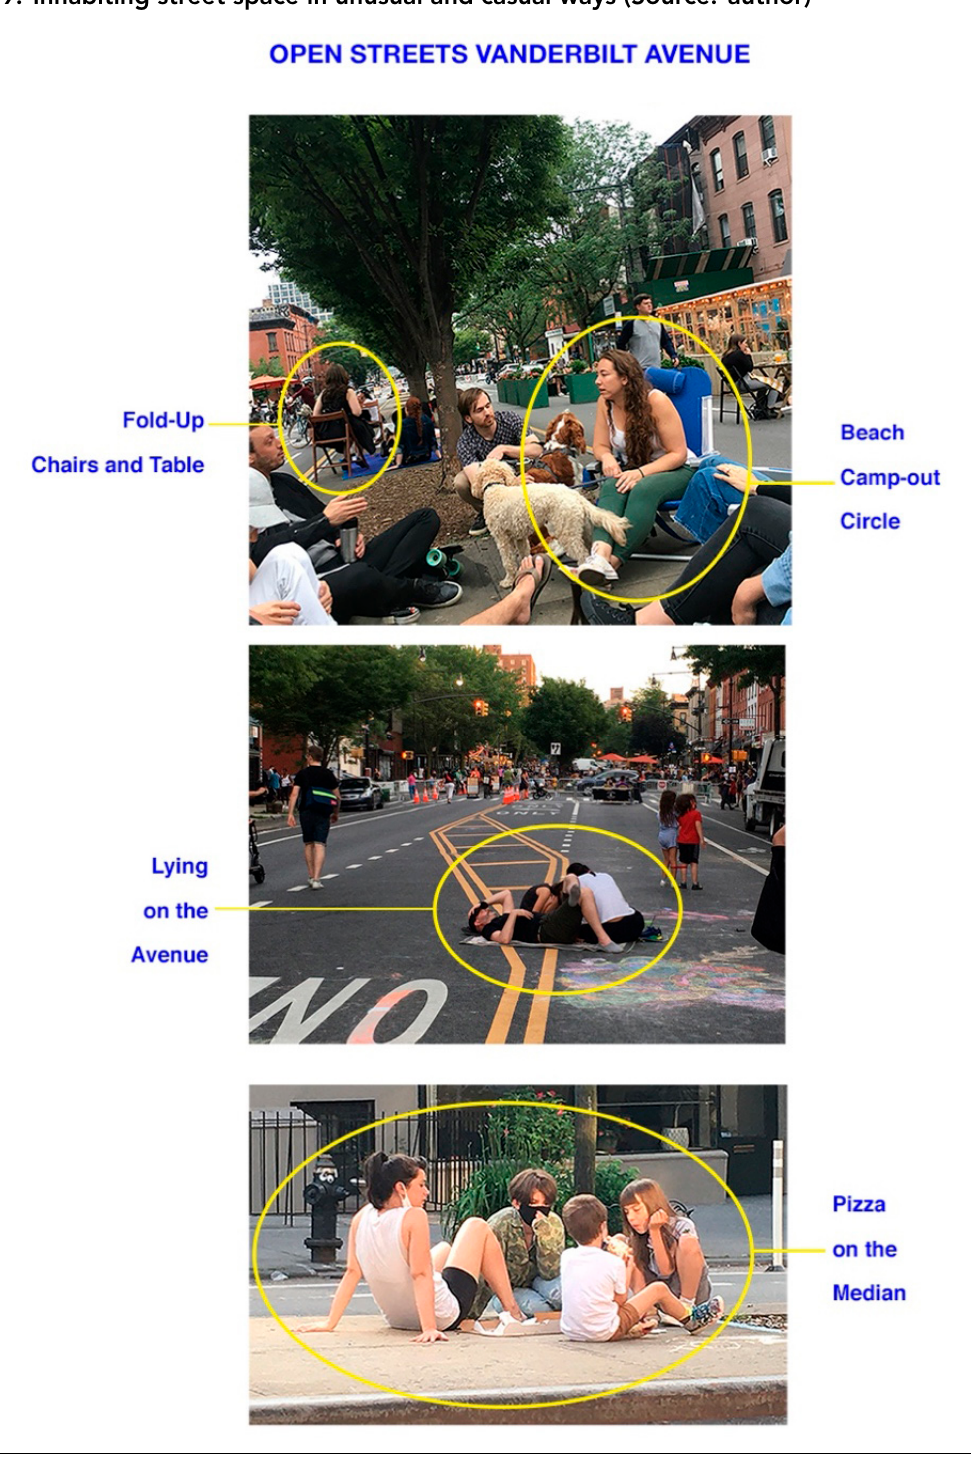
Figure 9. Inhabiting street space in unusual and casual ways (Source: author)